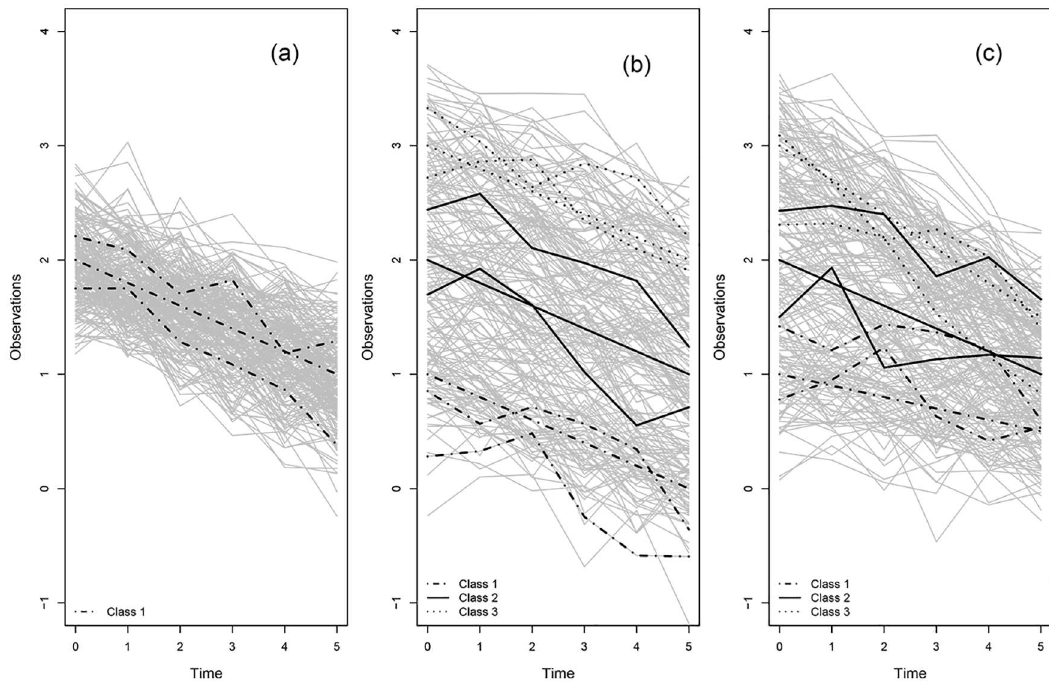
Fig 2. Longitudinal simulated data study. The left profile belongsto a homogeneous populationwith one class. The middleone belongsto a populationwith three classes where classes differ only in intercept, and the right profile belongsto a heterogeneous populationwith three classes where classes differ both in intercept and